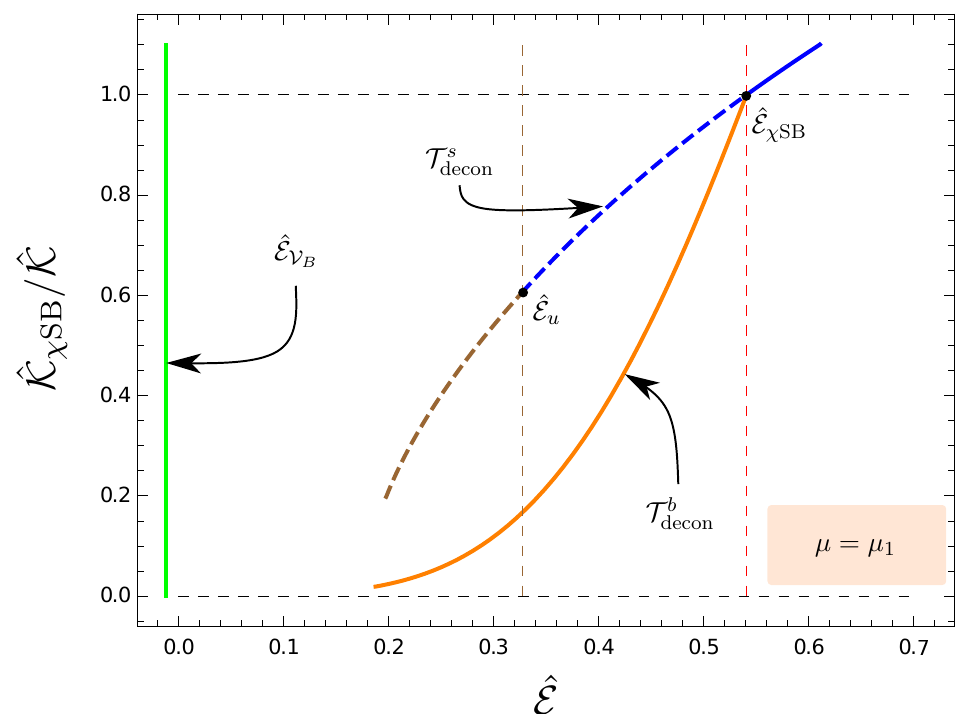
s = ˆ for states decon E E χ SB T